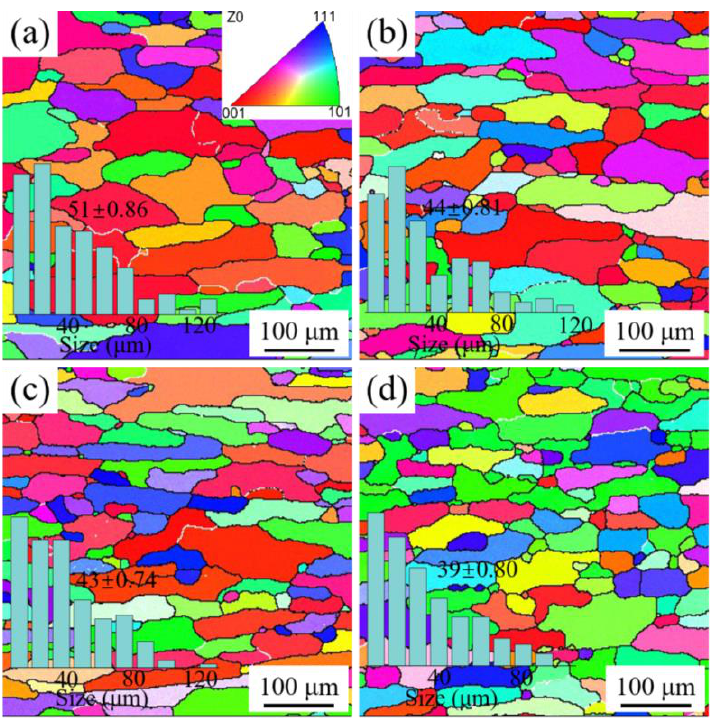
Figure 8. Orientation maps and inverse pole figure of the alloys after T6 treatment ( a ) AL1; ( b ) AL2; ( c ) AL3; ( d ) AL4.